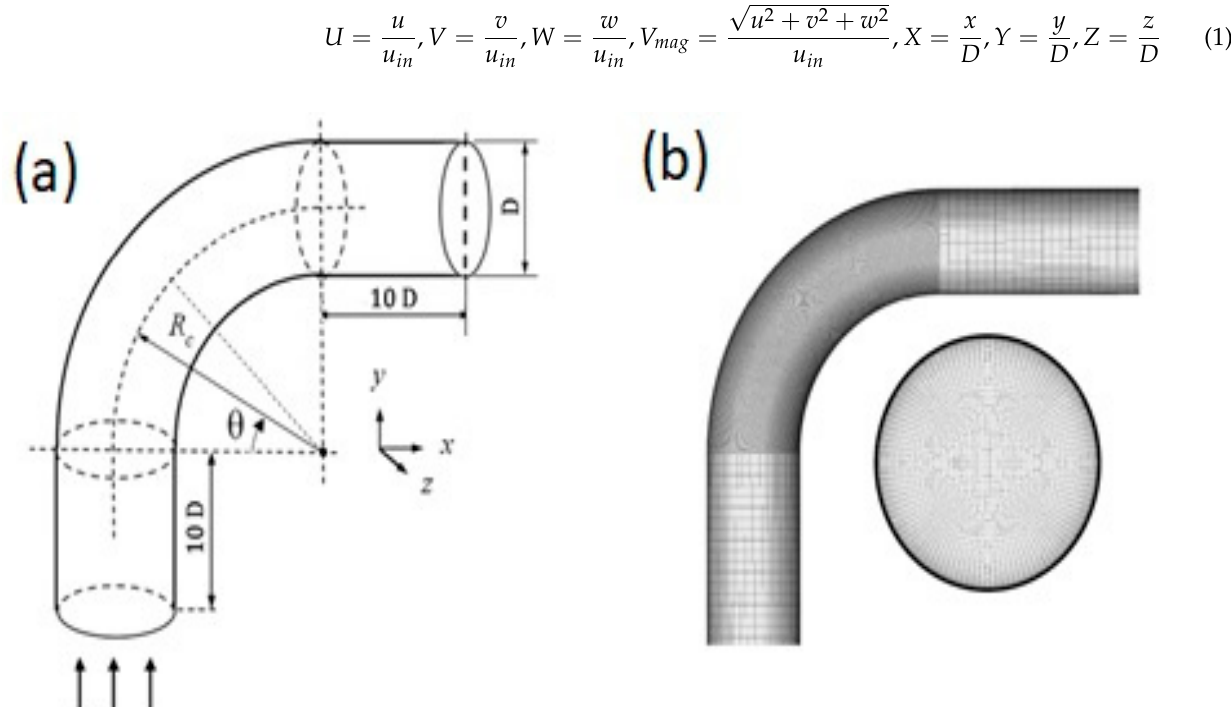
Figure 1. ( a ) Schematic diagram of the flow domain and ( b ) present CFD model with computational grid.